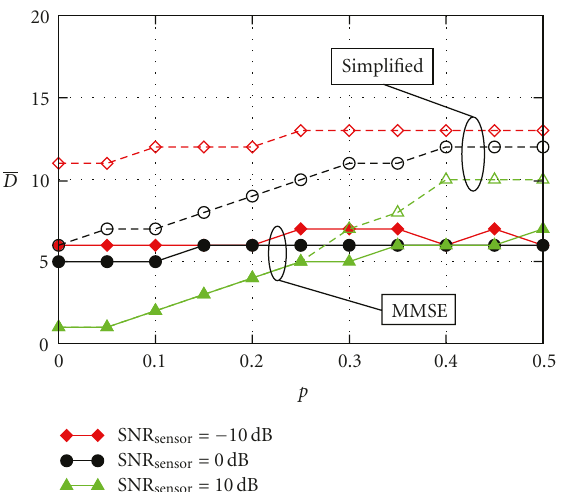
Figure 3: Distance, as a function of the cross-over probability p , in a scenario with N = 8 sensors and binary quantization. Three values for the sensor SNR are considered: (i) − 10 dB, (ii) 0dB, and (iii) 10dB. Both MMSE and simplified detection algorithms at the AP are considered.